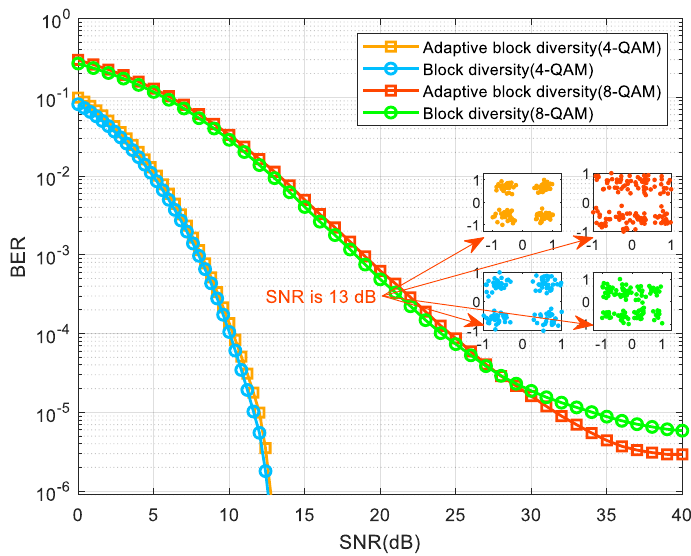
Figure 9. BER performance for transmitter and receiver aligned system.